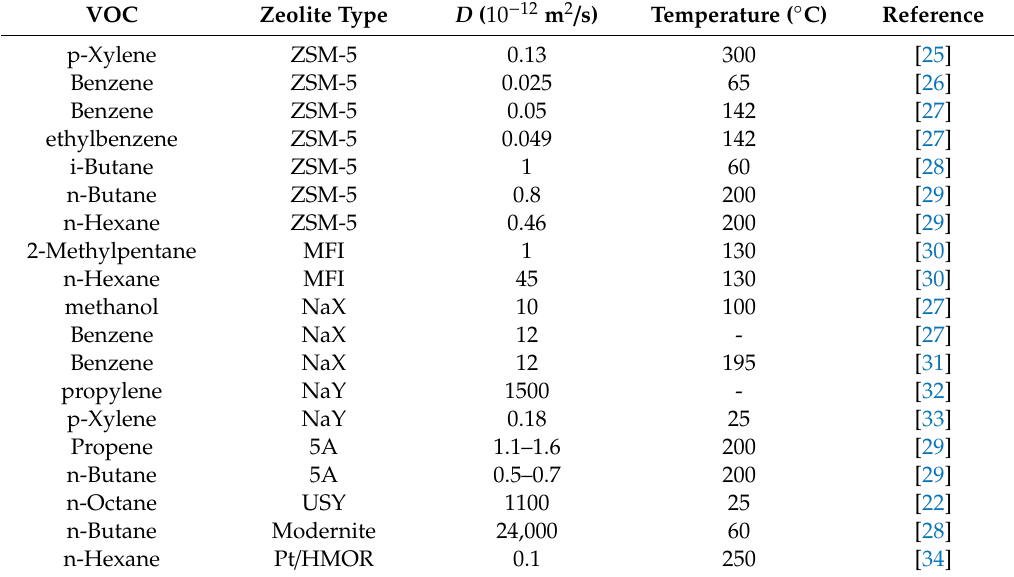
Table 1. Di ff erent di ff usion coe ffi cients for gas / zeolite pairs reported in the